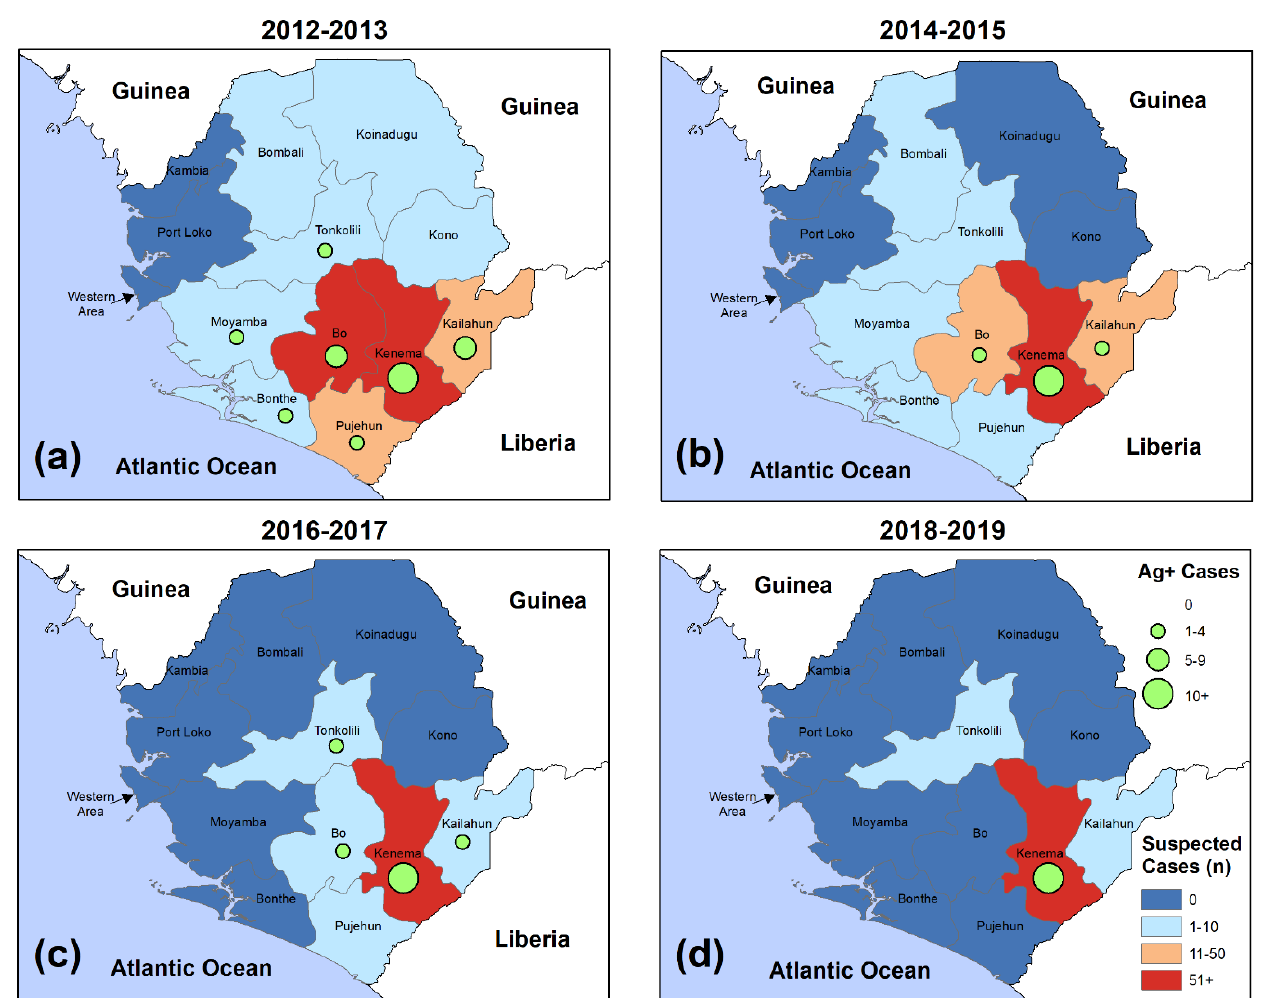
Figure 4. Suspected and confirmed Lassa fever cases screened at Kenema Government Hospital, 2012–2019. ( a ) Presentations between 1 January 2012 and 31 December 2013; ( b ) Presentations between 1 January 2014 and 31 December 2014; ( c ) Presentations between 1 January 2016 and 31 December 2017; ( d ) Presentations between 1 January 2018 and 31 December 2019. Following the 2014–2016 Ebola epidemic, suspected and confirmed cases were observed in closer proximity to Kenema District.